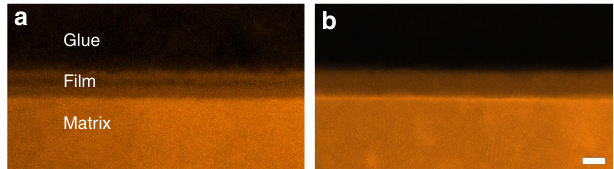
Fig. 1 HAADF-STEM image showing the contrast evolution of the passive fi lm on FeCr 15 Ni 15 single crystal on exposure to air. Scale bar, 5 nm. a Image immediately after the specimen was prepared. b Image after the